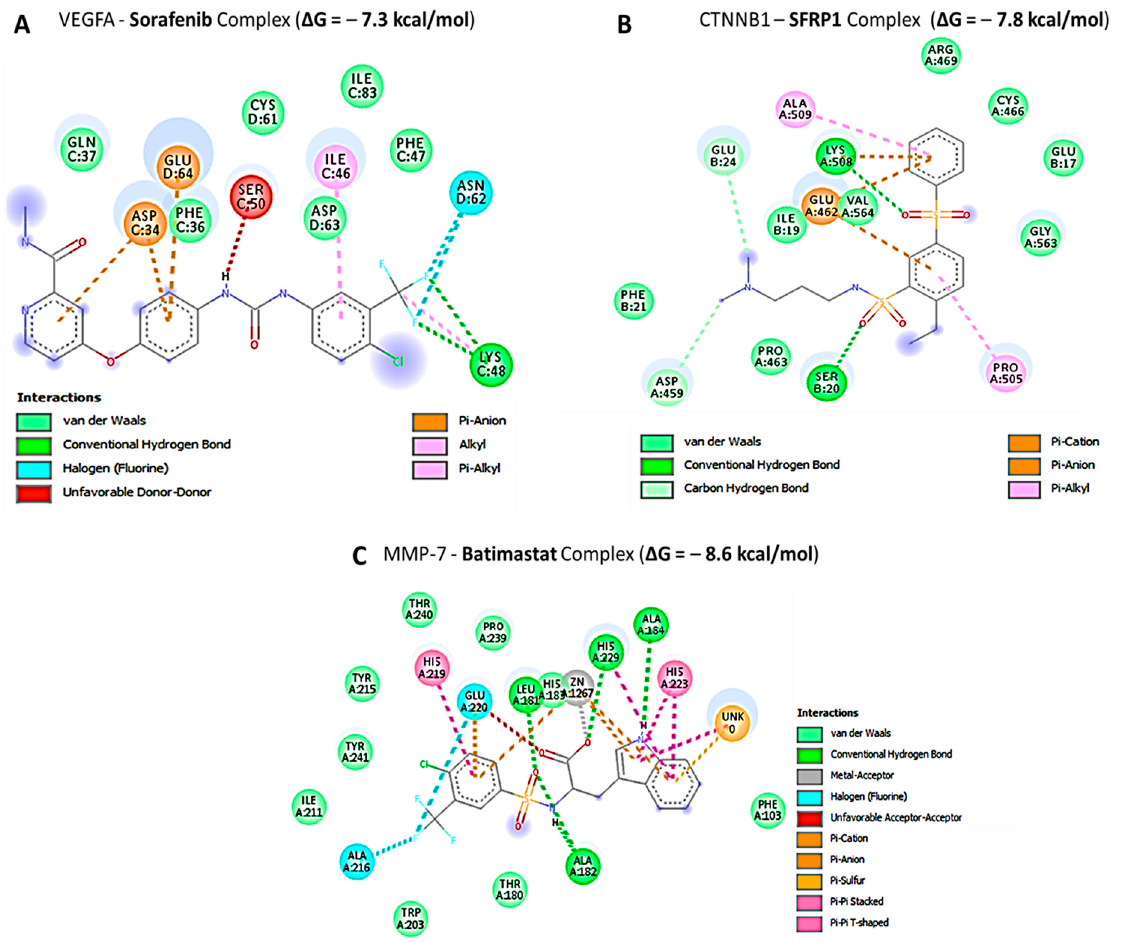
Figure 12. Two ‐ dimensional (2D) structural analysis of sorafenib, SFRP ‐ 1, and batimastat in com ‐ Figure 12. Two-dimensional (2D) structural analysis of sorafenib, SFRP-1, and batimastat in complex plex with VEGFA , CTNNB1 , and MMP7 ( A – C ), respectively. with VEGFA , CTNNB1 , and MMP7 ( A – C ),